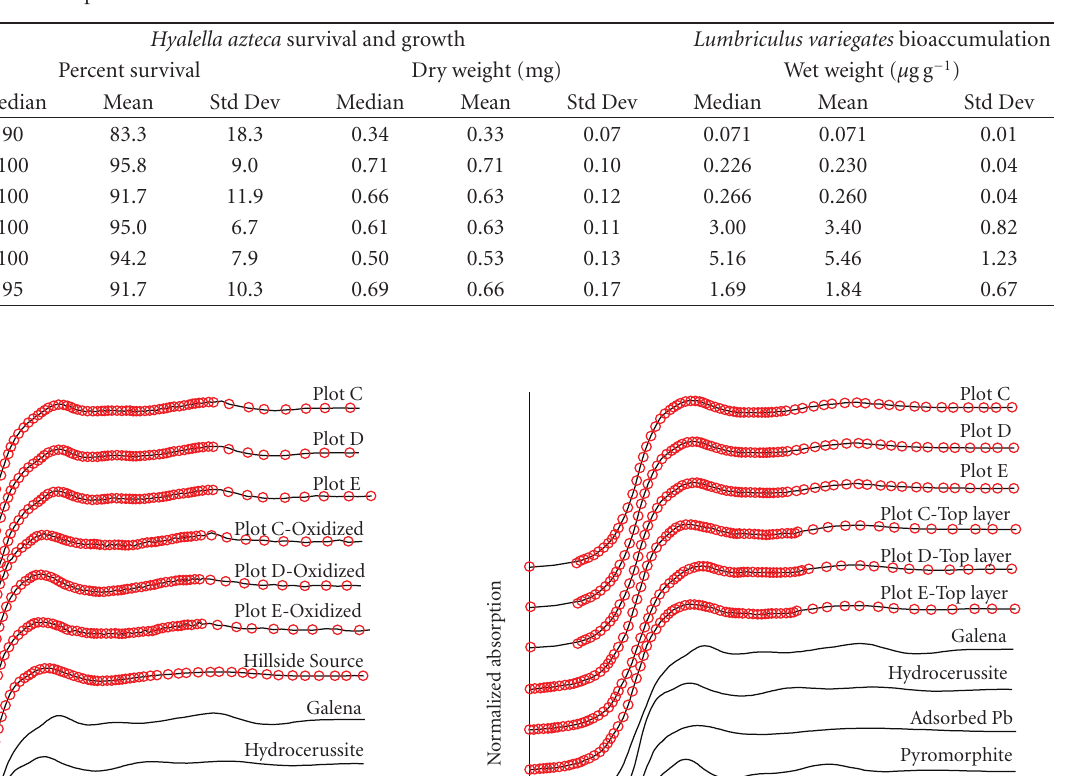
Table 4: Hyalella azteca survival and growth and Lumbriculus variegatus bioaccumulation data for Chopawamsic Creek sediment postamendment experimental plots.